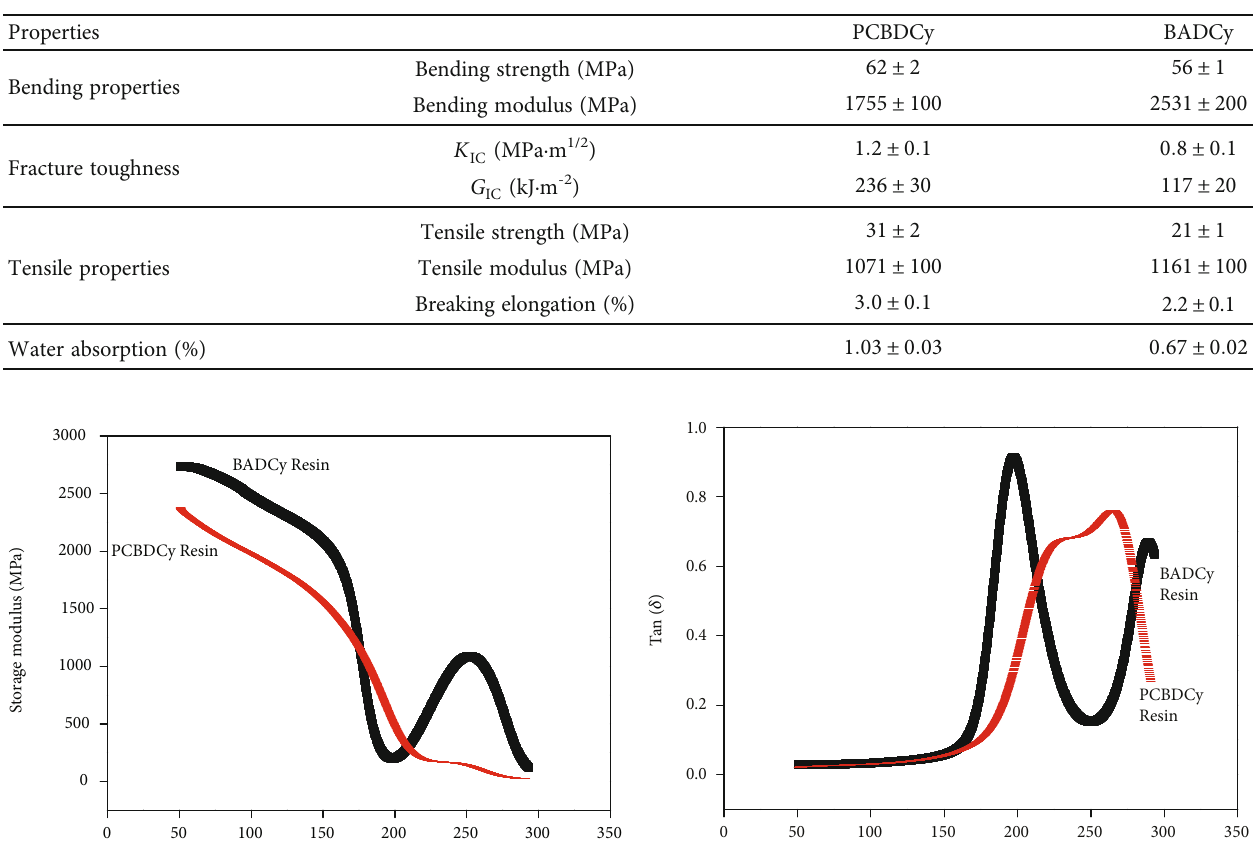
Table 2: Mechanical and water absorption properties of cured PCBDCy and BADCy.